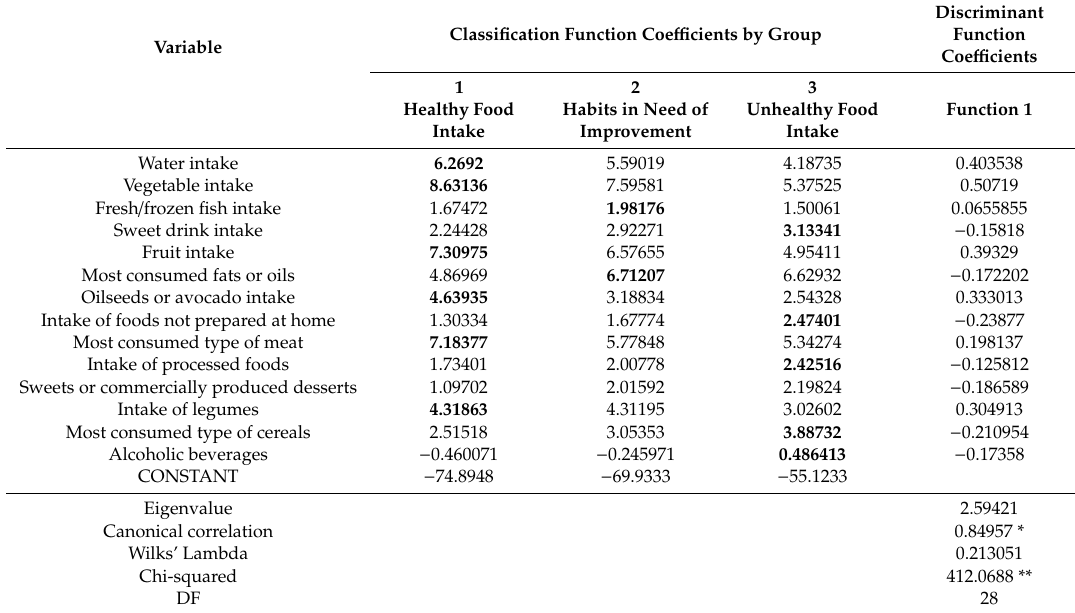
Table 4. Coe ffi cients of the classification and discriminant functions for food intake quality by group. Classification Function Coe ffi cients by Variable